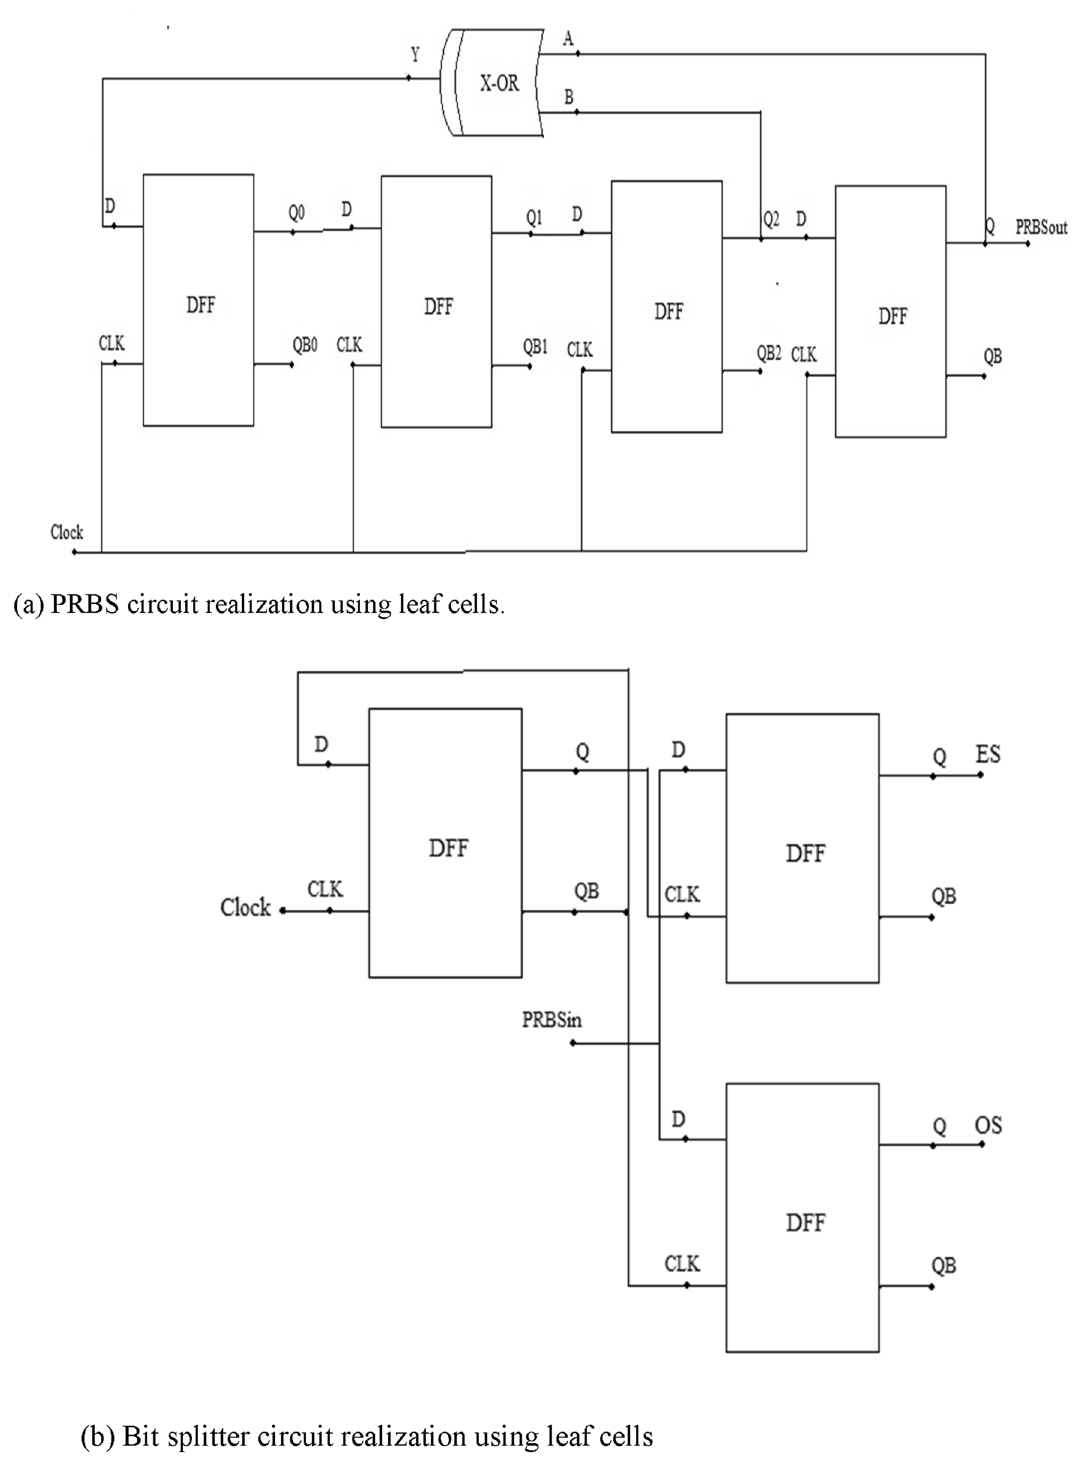
Figure 8. ( a ) PRBS circuit realization using leaf cells. ( b ) Bit splitter circuit realization using leaf cells. ( c ) Timing diagram of digital part of QPSK